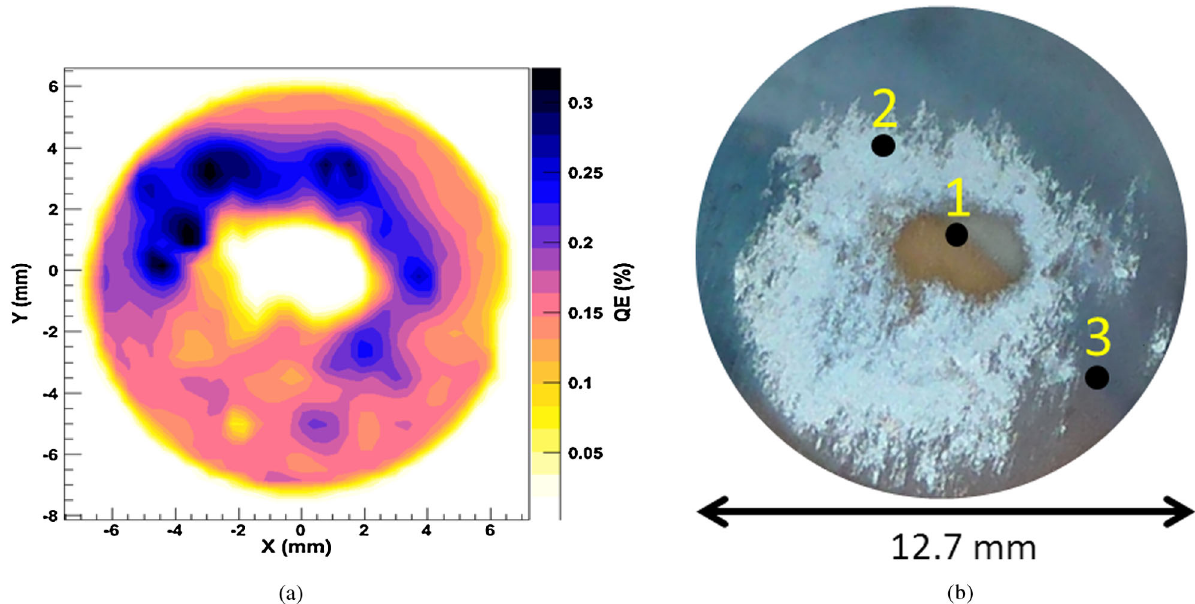
FIG. 16. (a) QE scan of photocathode #1 prior to transfer to the SEM and, (b) photograph of the photocathode showing the locations evaluated with SEM and EDS.